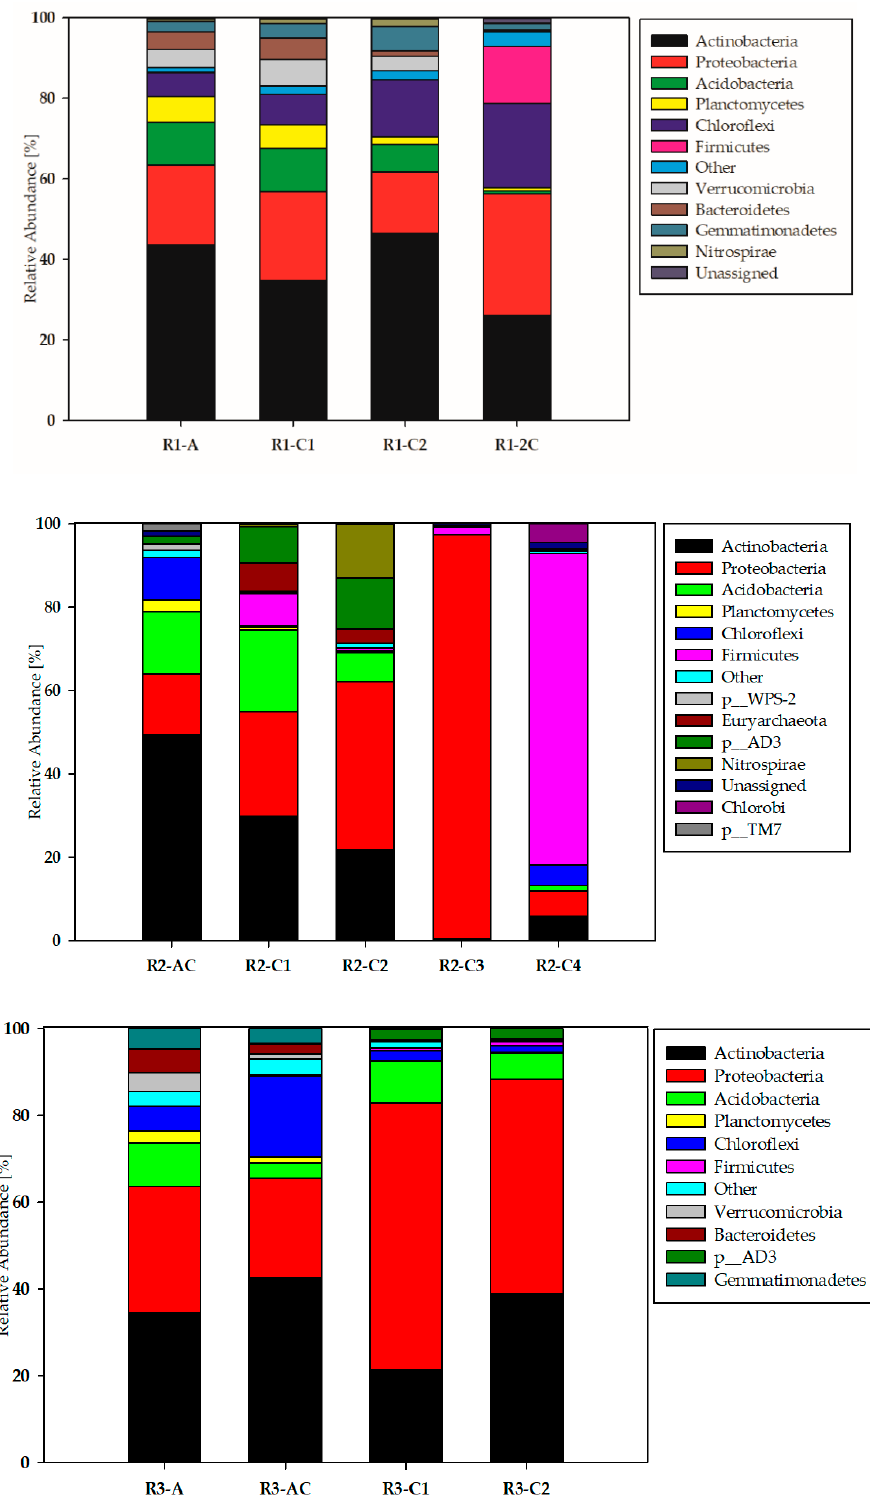
Figure 1. Main phyla of bacteria identified in the studied soils profiles (R1, R2 and R3) and horizons (A, AC, C1, C2, C3, C4, 2C).